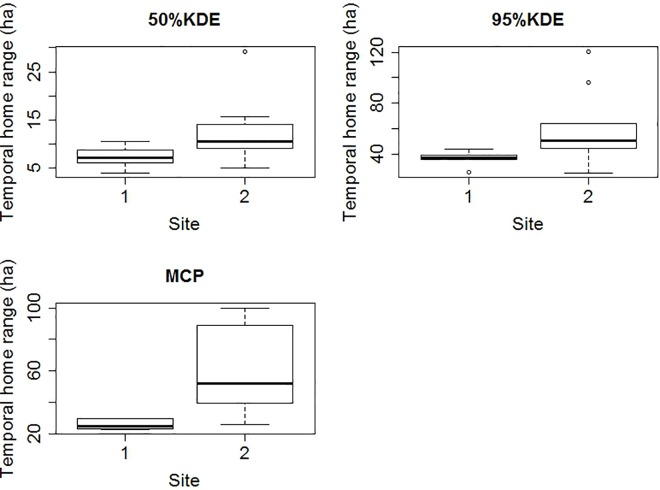
Box-plot for temporal home ranges of BTF calculated for 15 BTF in sites 1 and 2: 50%kde, 95%kde and MCP.